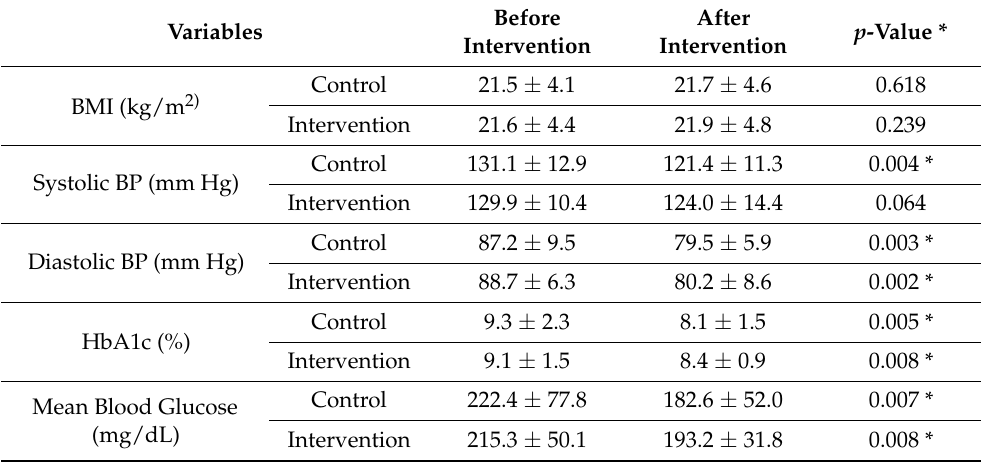
Table 4. Change in the body mass index, blood pressure and glycemic control before and after the intervention in the control and intervention groups.